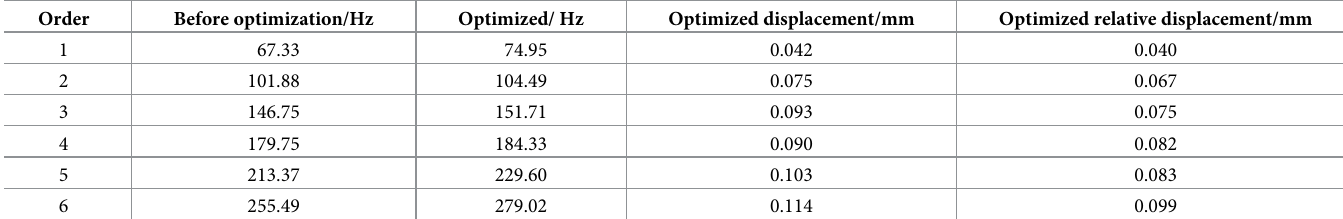
Table 7. Comparison of natural frequency before and after bed optimization.